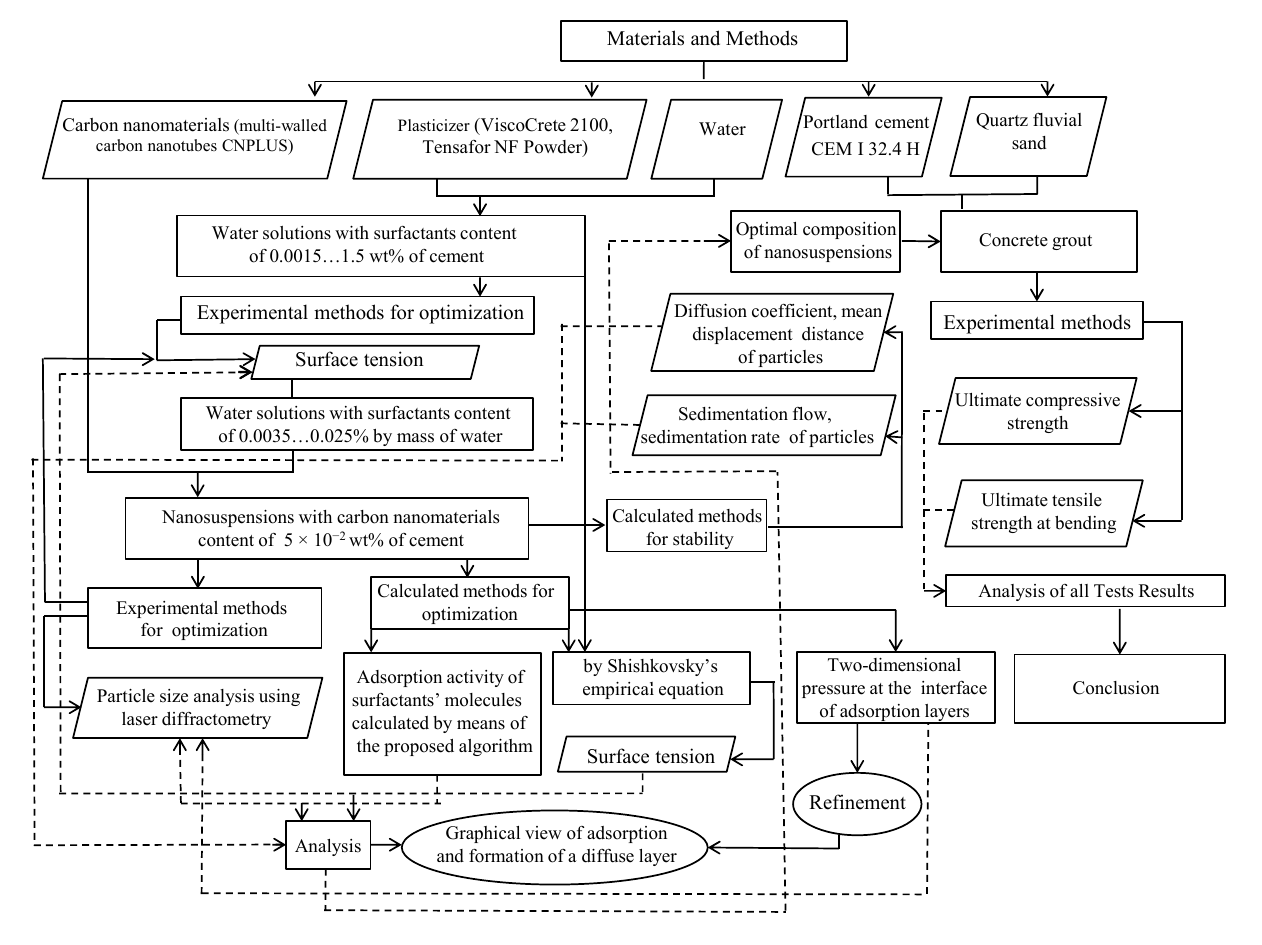
Figure 2. The flow chart of the research approach.